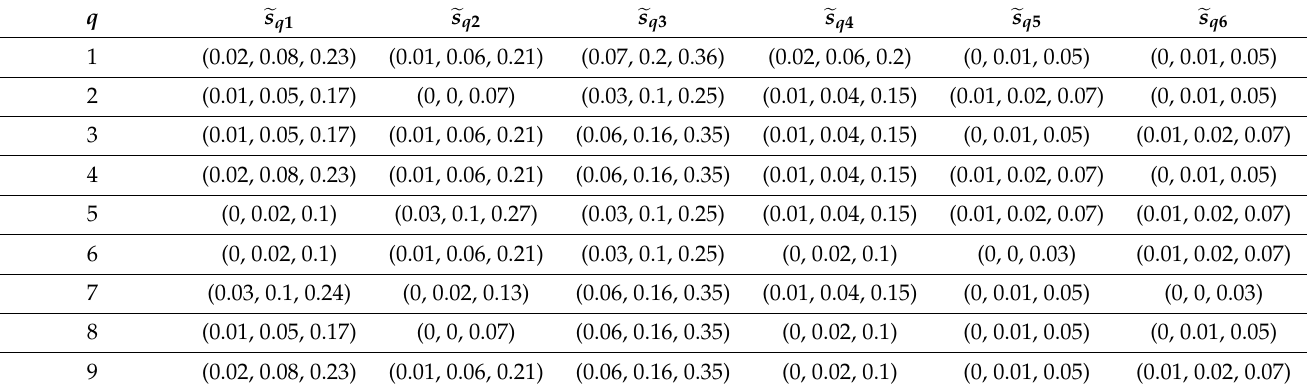
Table A2. Fuzzy prioritized scores of smart technology